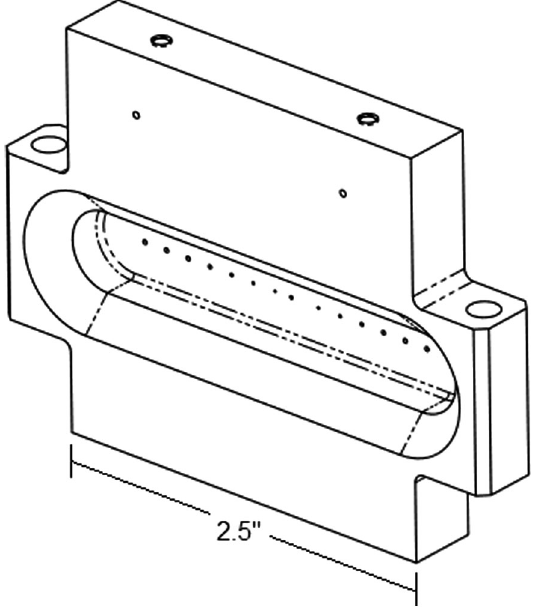
FIG. 4. Mechanical drawing of the 1D pepper pot.